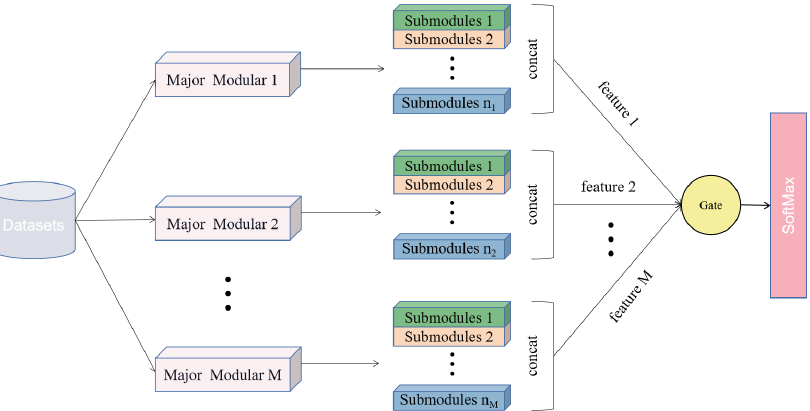
Figure 1. Overall Structure of Model. M refers to the number of modules. n M refers to module M containing n